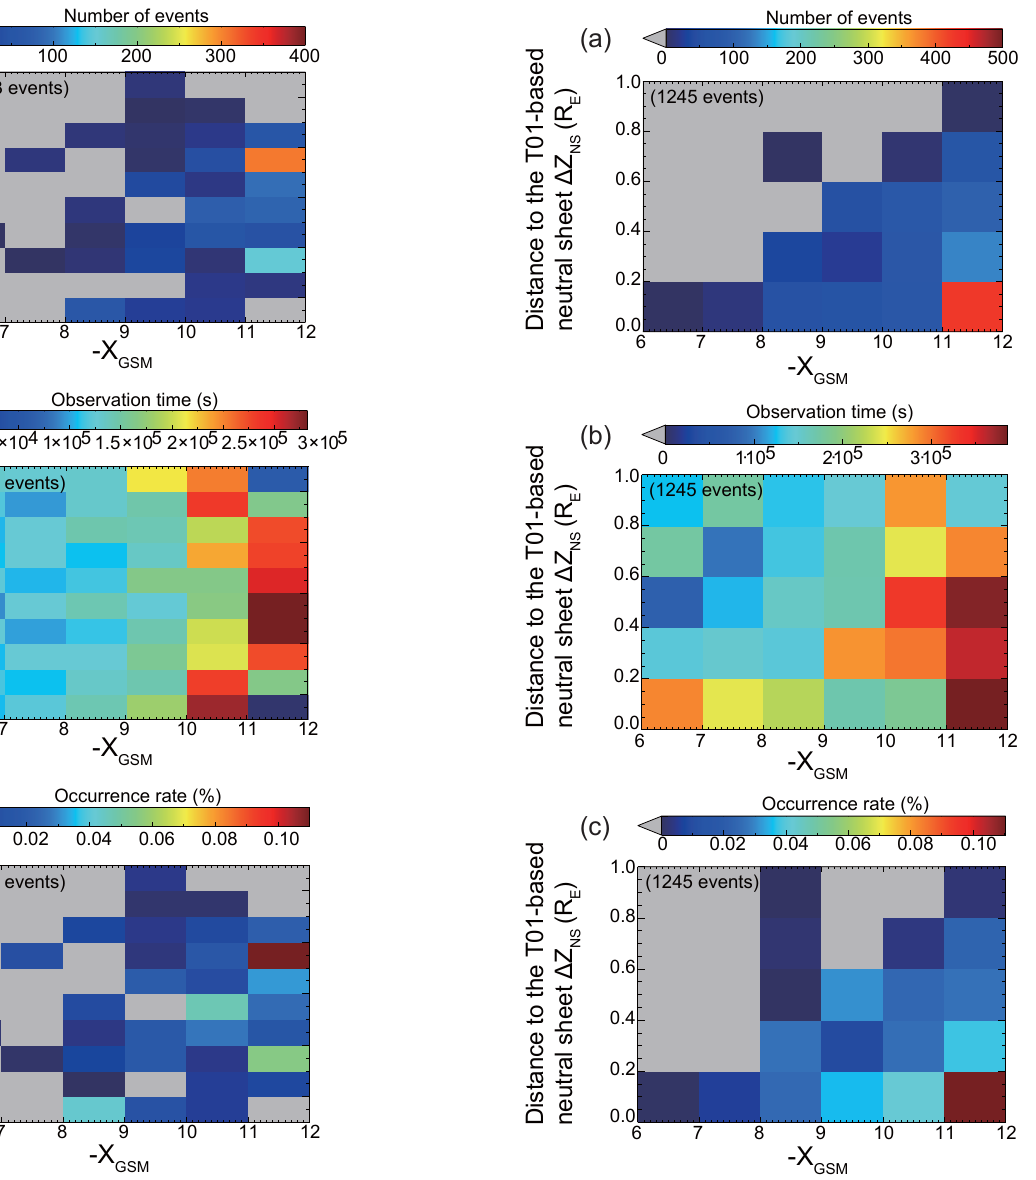
1 R E of (cid:49)Z NS , the occurrence rate of severe magnetic fluctu- ation events tends to increase when it becomes closer to the neutral sheet. The occurrence rate of magnetic fluctuations is highest at the neutral sheet, which is consistent with the basic idea of the inside-out